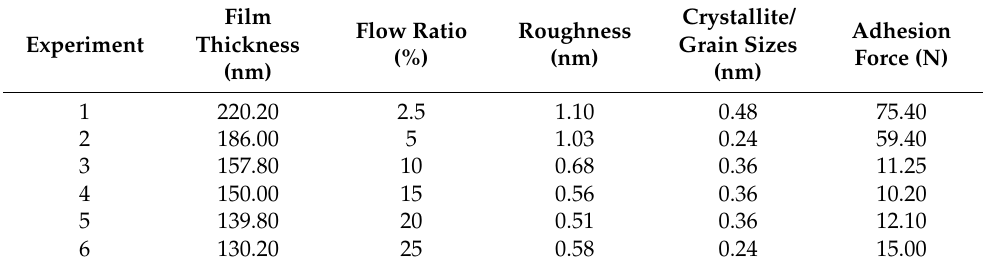
Table 1. Synthesis Conditions of TaN